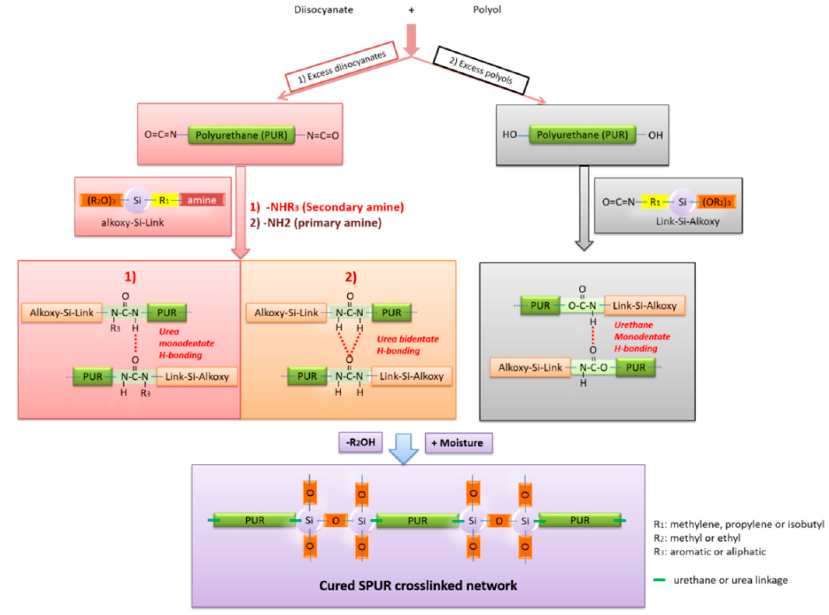
Figure 1. Two general routes for SPUR synthesis.